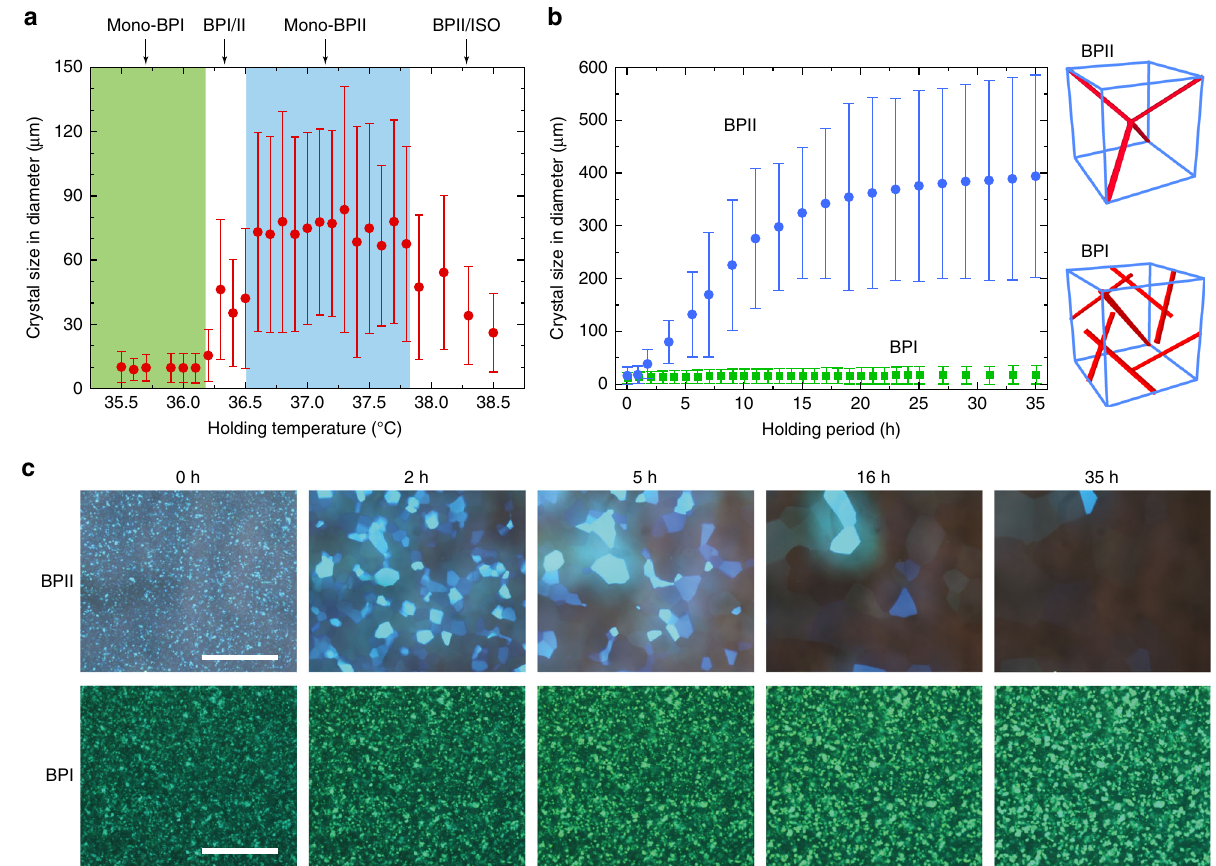
Fig. 1 Self-reassembly of a BPLC. a Crystal size of BPLC M1 as a function of holding temperature/phase, measured after holding the sample at the respective temperatures for three hours upon cooling from the ISO phase. b Sizes of BPII and BPI monocrystals as a function of holding time; the insets show the defect structures in unit cells of BPII and BPI, respectively. The data points for a , b were obtained by averaging the areal size of all platelets within the fi eld of view; error bar indicates the deviation from the average size. Each platelet is approximated by an enclosing circle of diameter D . The deviation σ P ð D (cid:2) D Þ 2 (cid:4) 1 = 2 , where D is calculated by the formula: σ ¼ ½ð N (cid:2) 1 Þ (cid:2) 1 (cid:3) 0 0 is the average diameter and N is the number of platelets. c Microscope images of BPII and BPI crystals as a function of time ( scale bars , 500 μ m). See “ Methods ” for experimental